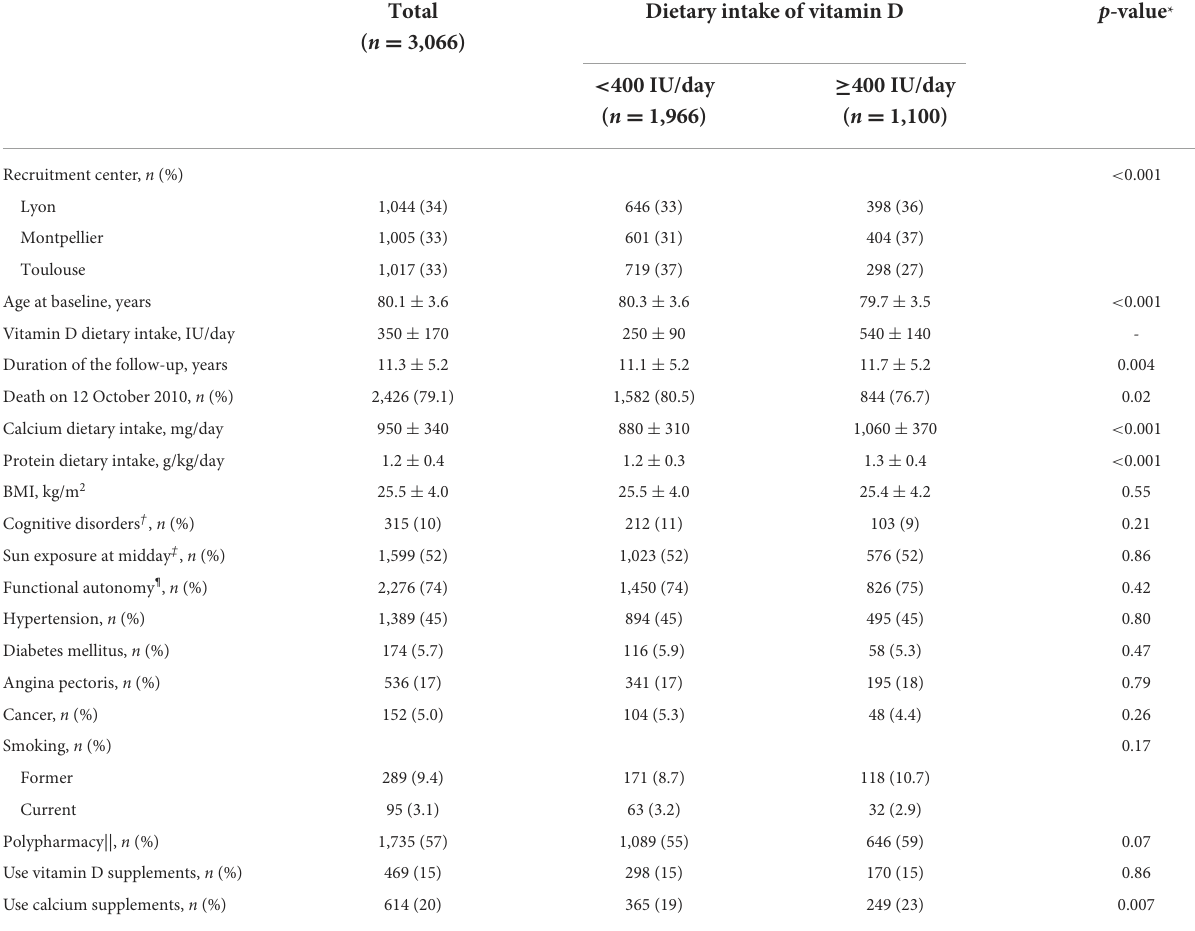
TABLE 1 Characteristics of study participants ( n =